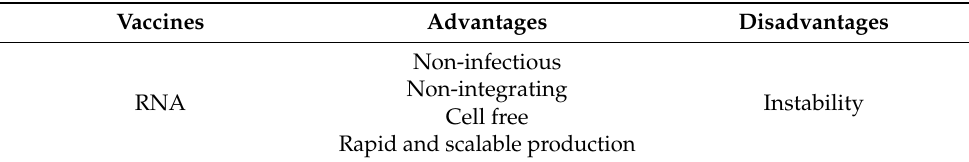
Table 1. Advantages and disadvantages of RNA vaccines.